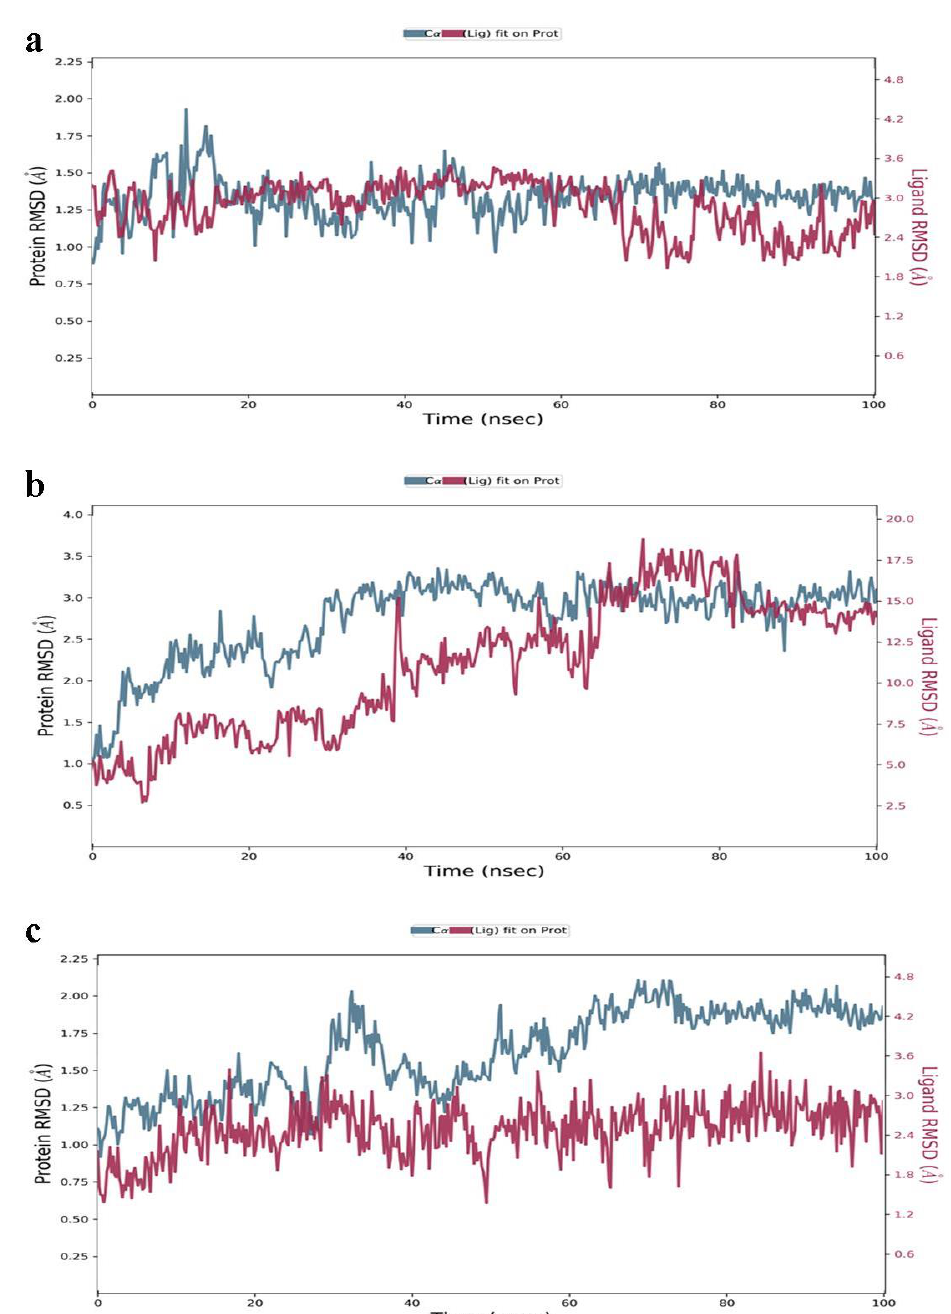
Figure 6. ( a – c ) Statistical investigation of the intermolecular stability and dynamics of the complexes based on molecular dynamics simulations.